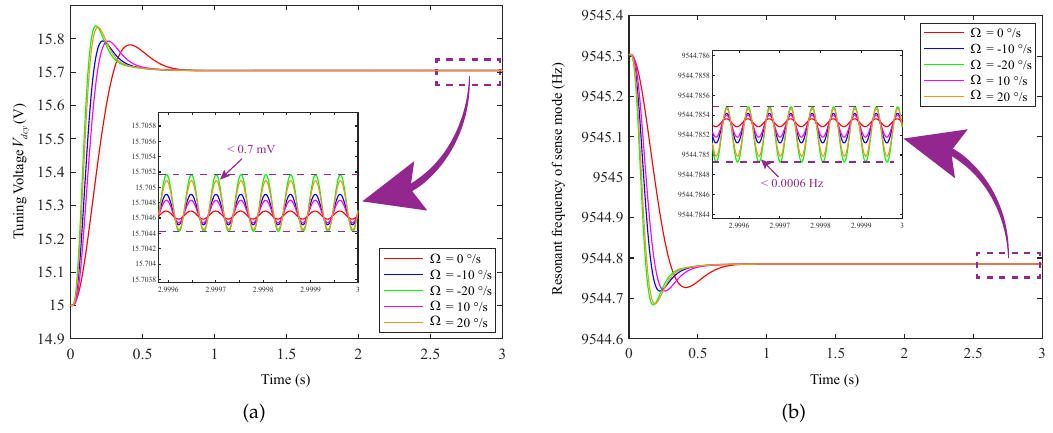
Figure 7. Influence of different input angular rates on tuning voltage and resonant frequency: ( a ) influence of different input angular rates on tuning voltage V dcy ; ( b ) influence of different input angular rates on resonant frequency f yy of sensing mode.